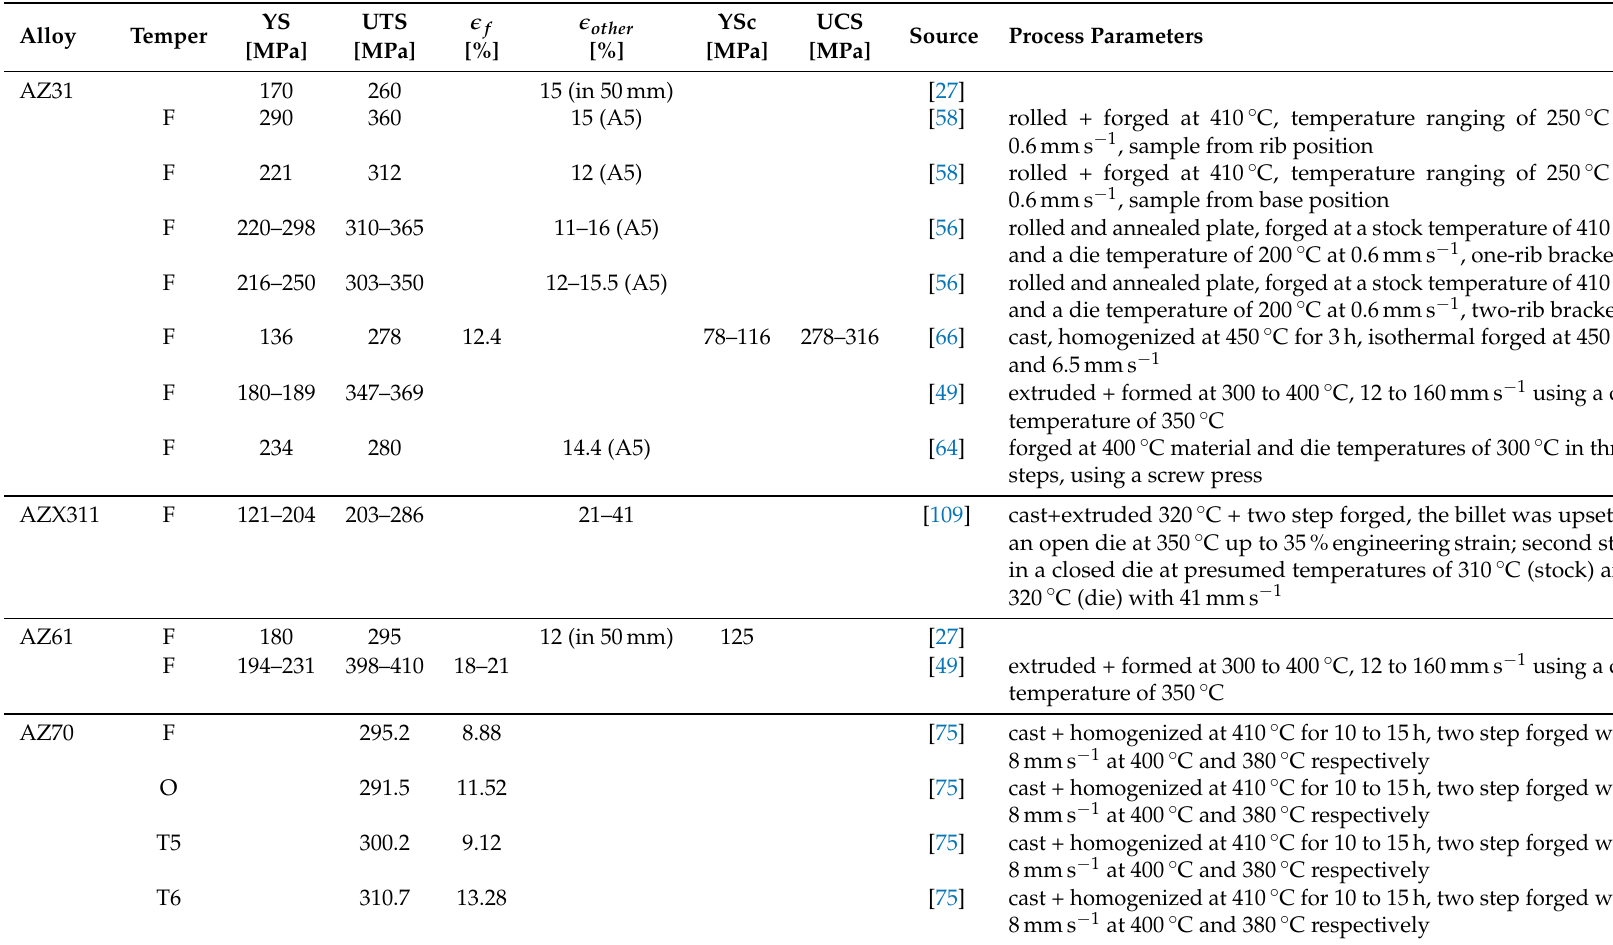
Table A5. Mechanical properties of various forged Mg alloys tested at room